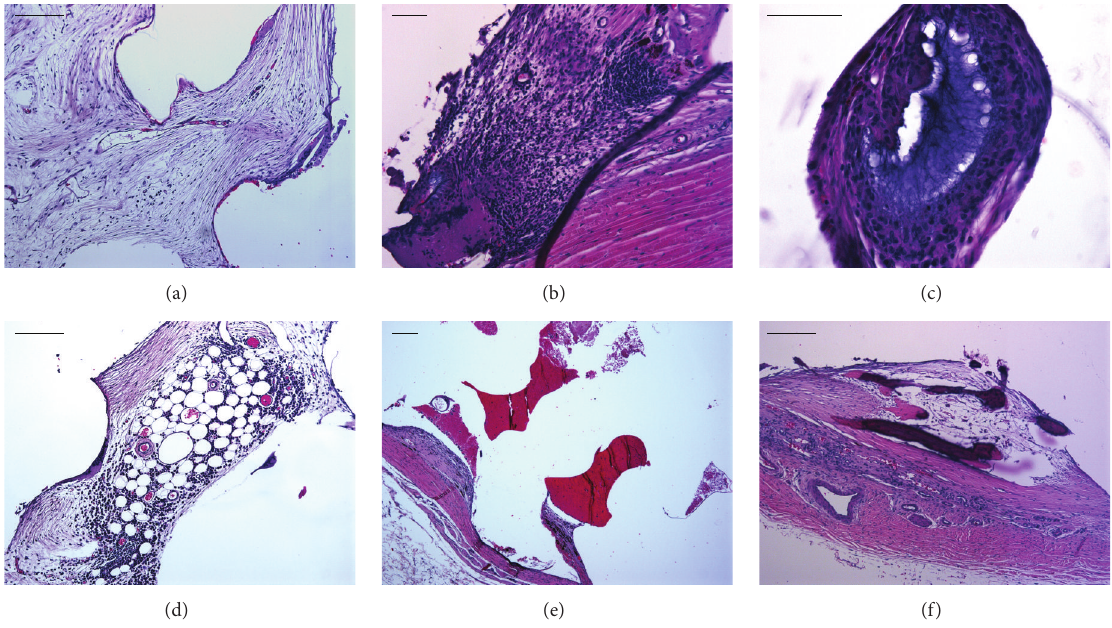
Figure 4: Histological findings in hematoxylin & eosin (HE) stained sections at 180 days after orbital implantation. Loose granulation tissue (a) with an associated foreign body giant cell reaction ((b), (c)) was commonly observed at 90 and 180 days after MEDPOR, OCULFIT I, and OCULFIT II implantation. Metaplastic changes (d), focal intraocular hemorrhage (e), and focal osseous metaplasia (f) were occasionally observed at 180 days after MEDPOR, OCULFIT I, and OCULFIT II implantation, respectively. Scale bars: 50 𝜇 m ((a), (d), MEDPOR; (e), OCULFIT I; (f), OCULFIT II) and 20 𝜇 m ((b), OCULFIT I; (c), OCULFIT